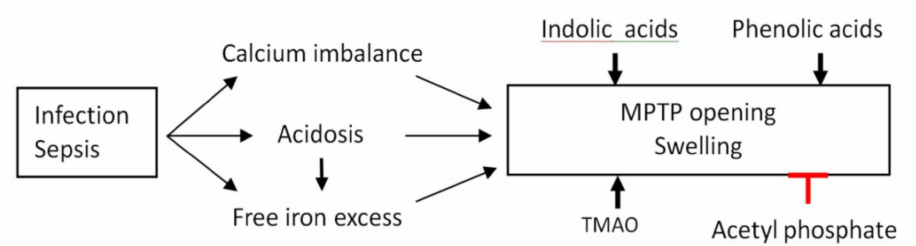
Figure 7. Contribution of microbial metabolites to the regulation of mitochondrial membrane permeability under conditions associated with infections and sepsis. The activation of the listed processes is shown with black arrows, the inhibition highlighted by a red